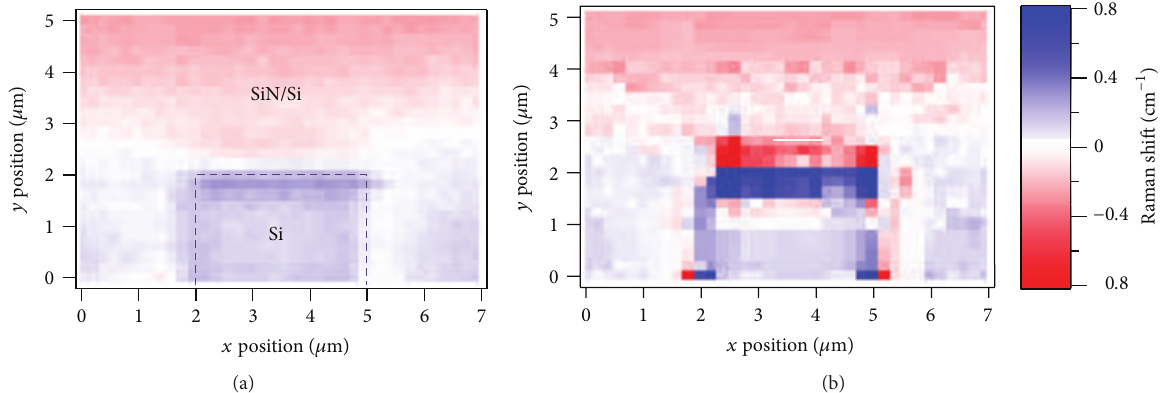
Figure 6: Two-dimensional distributions of the Raman shifts in the end of L&S pattern obtained by (a) conventional and (b) super-resolution Raman measurements with conventional